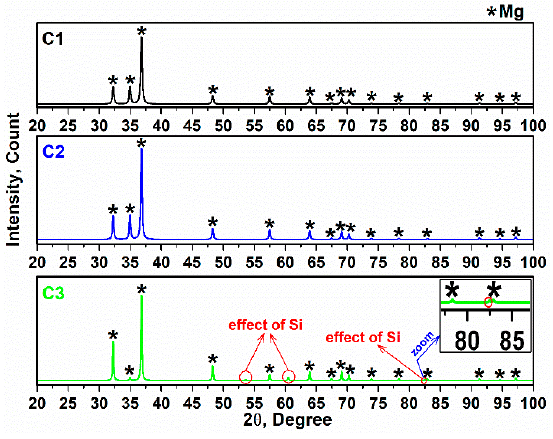
Figure 4. X-ray diffraction of composites.